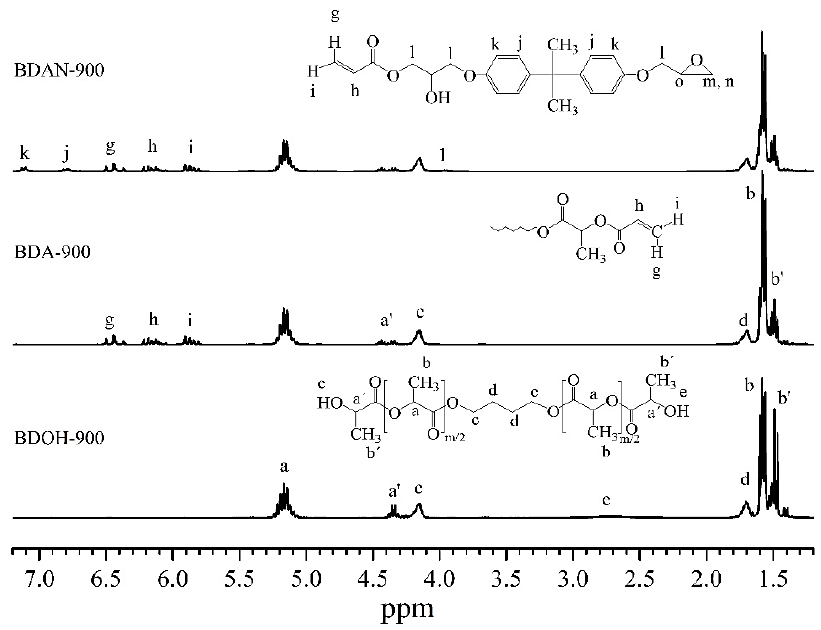
Figure 6. 1 H-NMR spectra of BDOH-900, BDA-900, and BDAN-900.